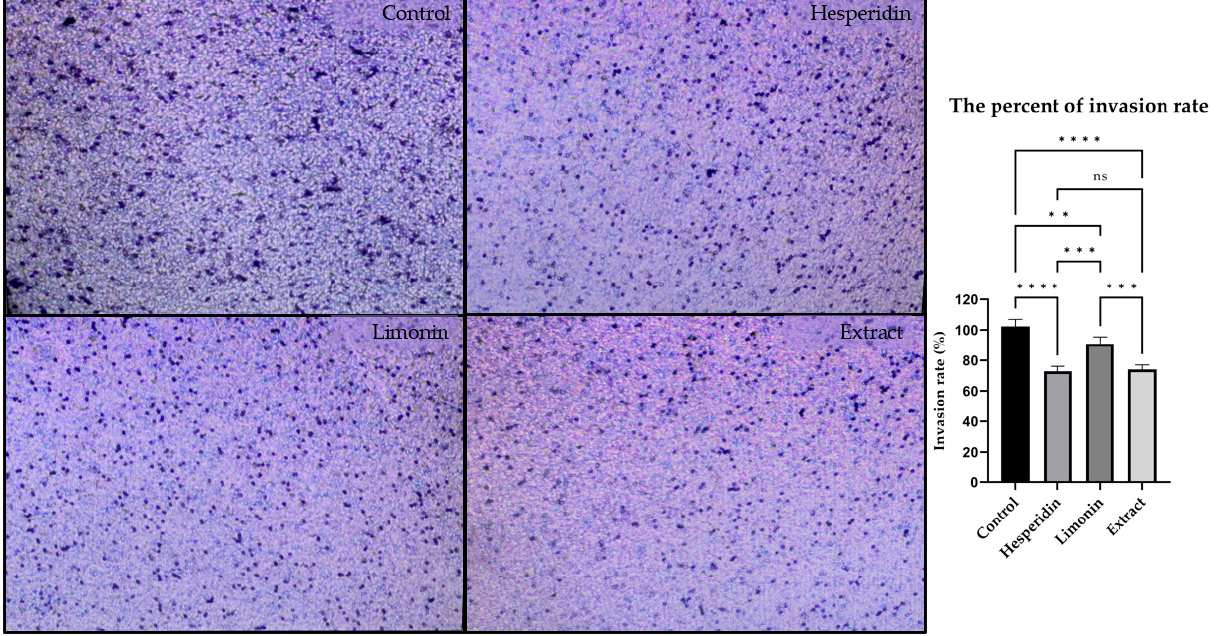
Figure 5. Representative images (Left) and percent invasion rate (Right) of PLC/PRF/5 human hepa- tocellular carcinoma cells following 0.5% DMSO (negative control), hesperidin, limonin, and lime peel ethanolic extract treatment. The statistical differences were analyzed by using one-way ANOVA followed by the Bonferroni comparisons test. The symbol ns, **, *** and **** mean p > 0.05, <0.01, <0.001 and <0.0001, respectively. <0.01, <0.001 and <0.0001,